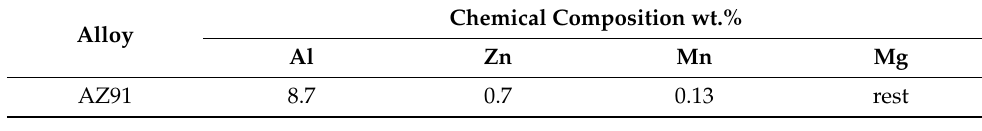
Table 1. Nominal chemical composition of used magnesium matrix alloy [31].